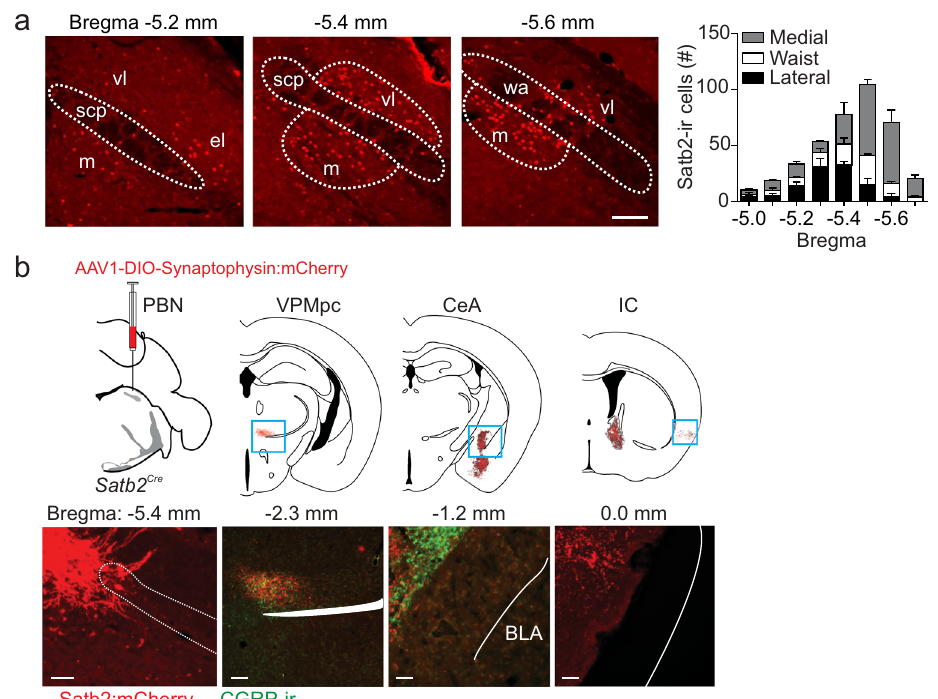
Fig. 1 Satb2 neurons are expressed in the gustatory PBN. a Immunostaining for Satb2 in the PBN and quanti fi cation of its expression across the rostral – caudal extent of the PBN ( n = 3 mice). scp superior cerebellar peduncle, vl ventral – lateral, m medial, wa waist. b Unilateral injection of AAV1-DIO- synaptophysin:mCherry in the PBN of Satb2 Cre mice and labeling of terminal fi elds in select brain regions ( n = 3 mice). The Satb2 – neuron projection overlaps with CGRP expression in the VPMpc, but not in the CeA. Scale bars, 100 µ m. Data are presented as mean ± SEM. Source data are provided as a Source Data fi